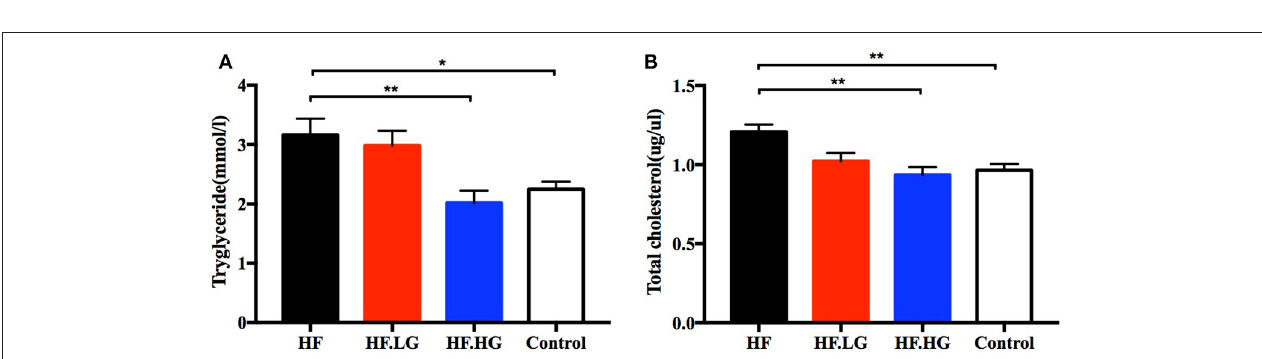
FIGURE 3 | Lipid metabolism of the female offspring at weaning. (A) Serum triacyglycerol; and (B) serum total cholesterol. HF, high-fat diet without genistein; HF. LG, high-fat diet with low-dose genistein; HF. HG, high-fat diet with high-dose genistein; Control, normal control diet. Data are expressed as means ± S.E.M ( n = 6-8/group). Mean values were significantly different between other group and the HF group: * p < 0.05, ** p <